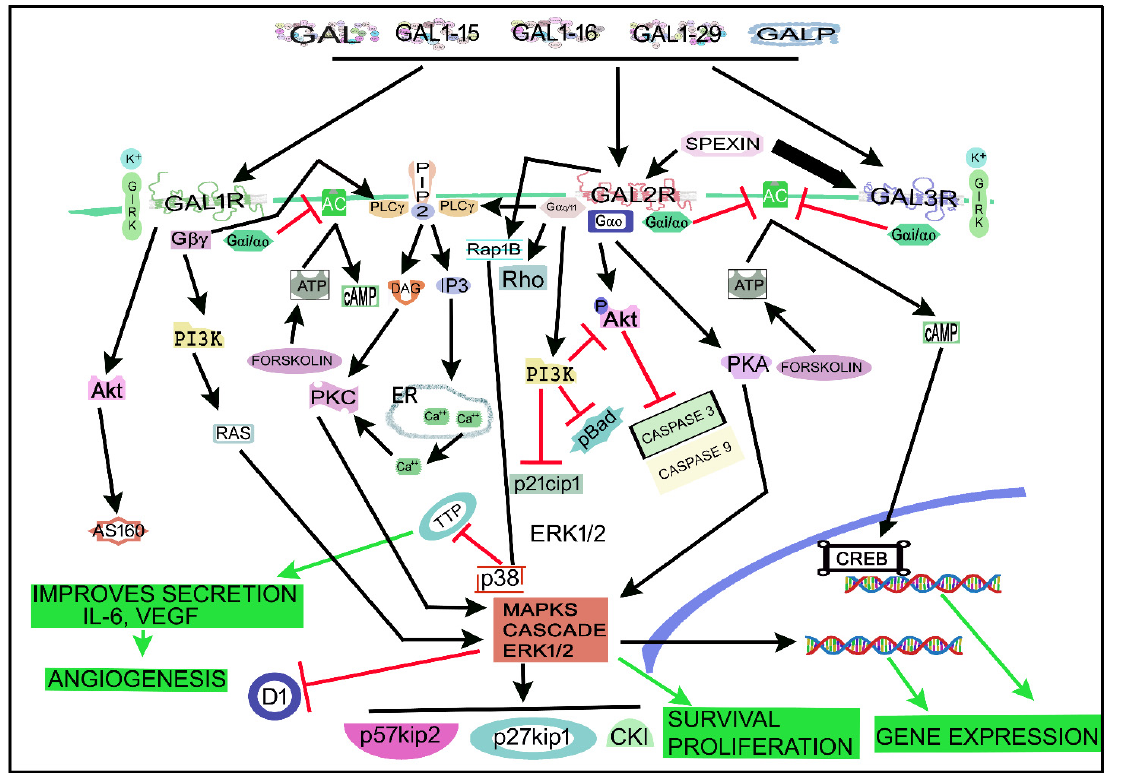
Figure 4. Main signaling pathways in which the galaninergic system is involved. Black arrows in- dicate activation pathways, inverted red “T” indicates blockade/suppression, green arrows mean final results. AC, adenylate cyclase; Akt, Akt serine/threonine kinase family (also called PKB);